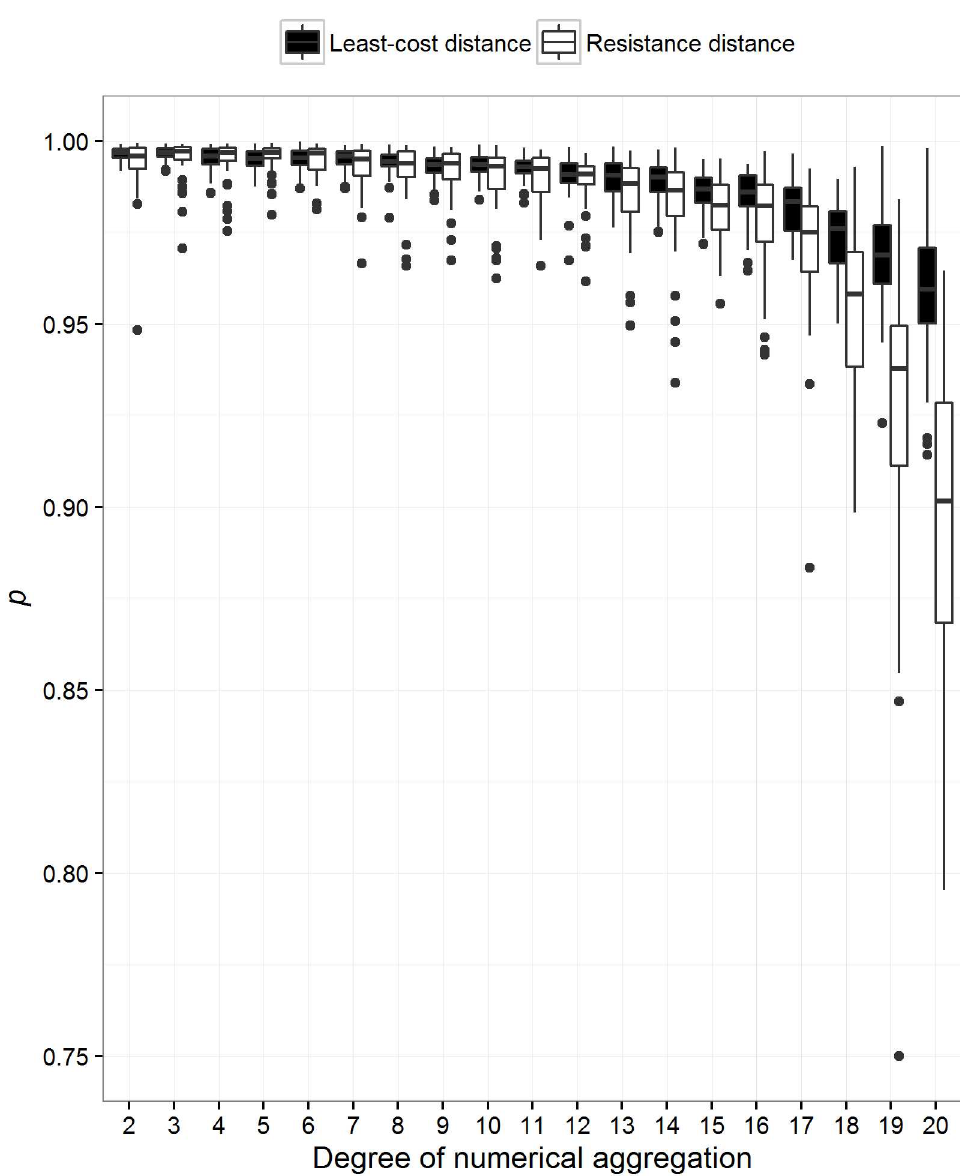
Fig 8. The effect of thematic aggregation on the relationship between least-cost and resistance distance. One thousandlandscapes were simulatedwith varyingdegreesof spatialautocorrelation. Least-cost and resistancedistancebetween15 sites was then calculatedfor all landscapes. The cost values on these landscapes were then aggregatedwithin discrete categorizes. The number of categorizes rangedfrom 2 to 20 discrete cost values. A cost surface with 20 discrete cost values would represent a land use land cover map and 2 discrete cost values wouldrepresent a binary surface. The degreeof data aggregationis ‘22—the number of discrete classes’. This means that if cost values were aggregatedinto 2 discrete classes the degreeof thematic aggregationwas 20. Pairwisedistances were once again calculated. We then calculatedthe Spearman’srank correlationbetweeneach method before and after aggregation. This figure illustrates that thematic aggregation decreasesthe agreementbetween the rankings of the distances. The effect is more apparentfor resistance distancecompared to least-cost